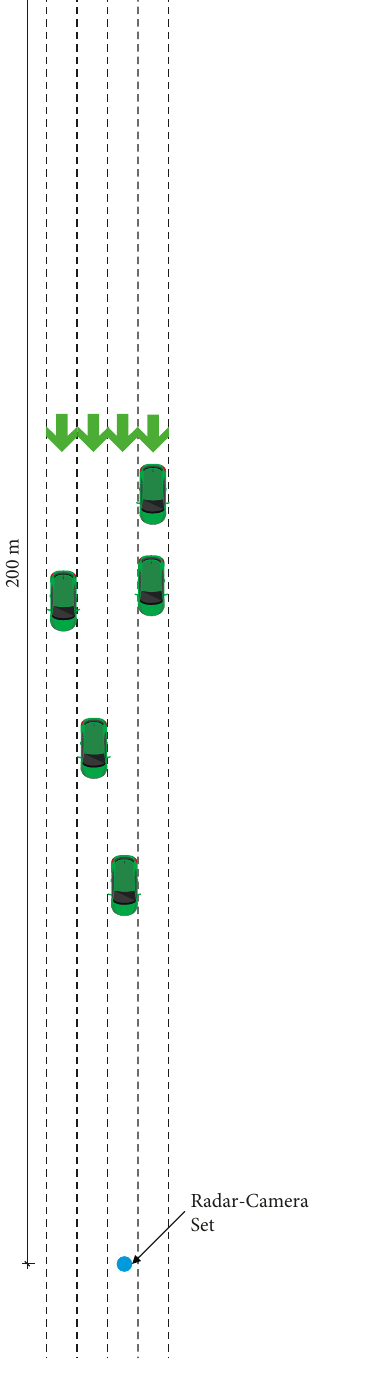
Figure 15: Long straight road